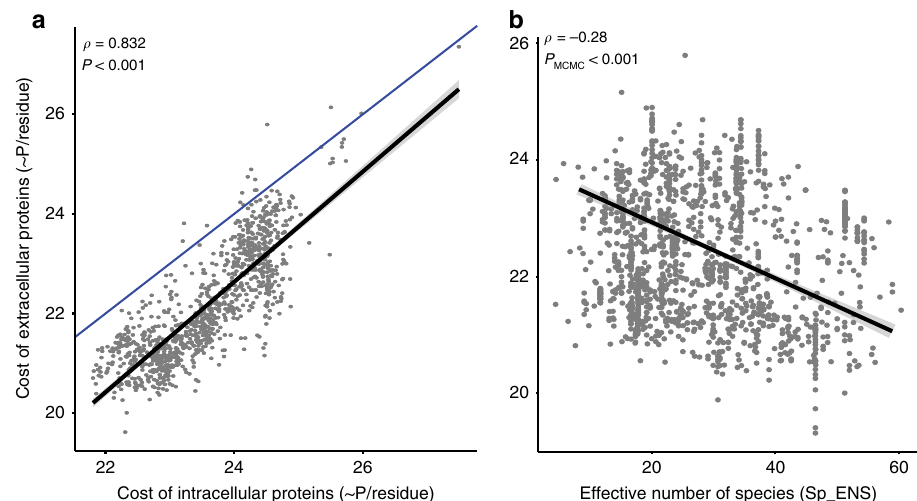
Fig. 5 Relatioship between the biosynthesis cost and the genomic and environmental features. a Comparison between the average biosynthesis cost per residue of extracellular and intracellular proteins. The two variables are correlated, but on average the extracellular proteins have less costly amino acids (Wilcoxon Rank test, P < 10 − 10 ). The blue line represents the identity line while the black line indicates the linear regression (statistics: a = 1.229, b = − 6.623, R 2 = 0.683, P < 10 − 16 ). b Association between the average amino acid cost of extracellular proteins and the average Effective number of Species across the samples where a species was identi fi ed, regression statistics: a = − 1.449, b = 71.589, R 2 = 0.103, P < 10 − 16 ). Points represent individual species. Source data are provided as a Source Data fi le.